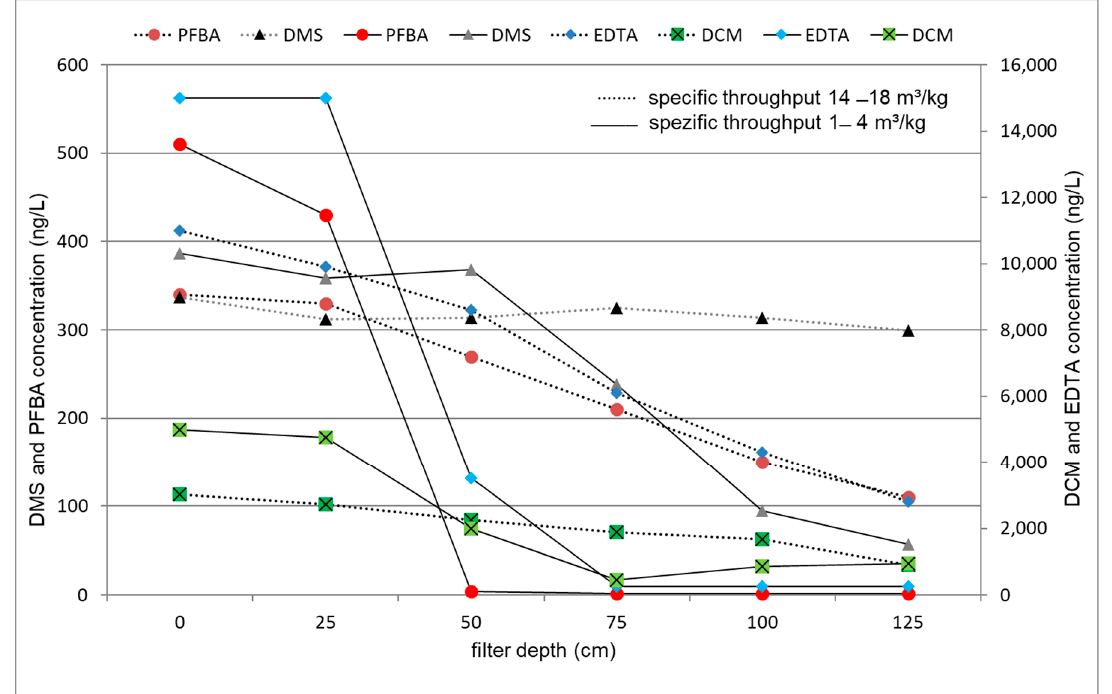
Figure 5. Depth-dependent concentration profiles for TrOCs in ACF filter.